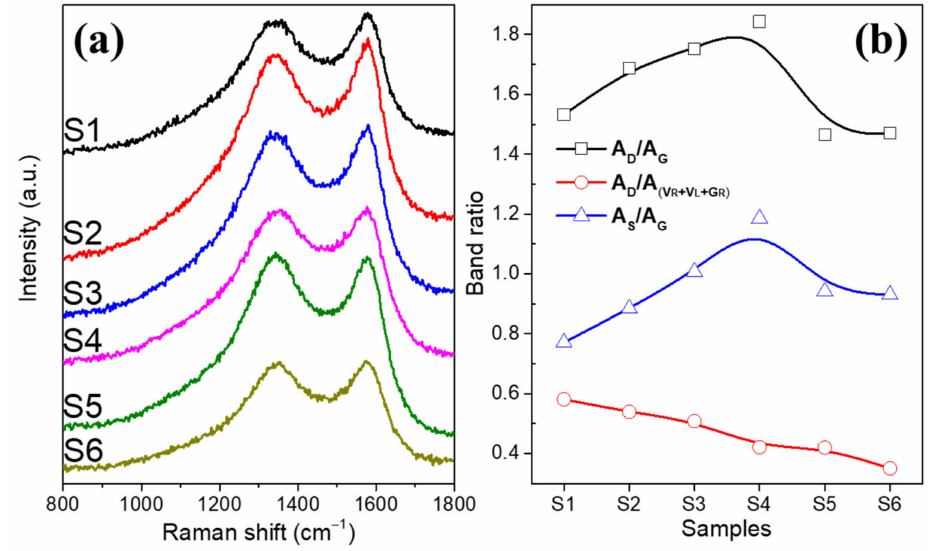
Figure 2. Raman spectrums ( a ) and their corresponding band area ratios ( b ) of AWTCs. With the assistance of 10-peak method, the key band area ratios of A D /A G , A D / A (VR+VL+GR) , A S /A G of the chars at six stages were calculated and drawn in Figure